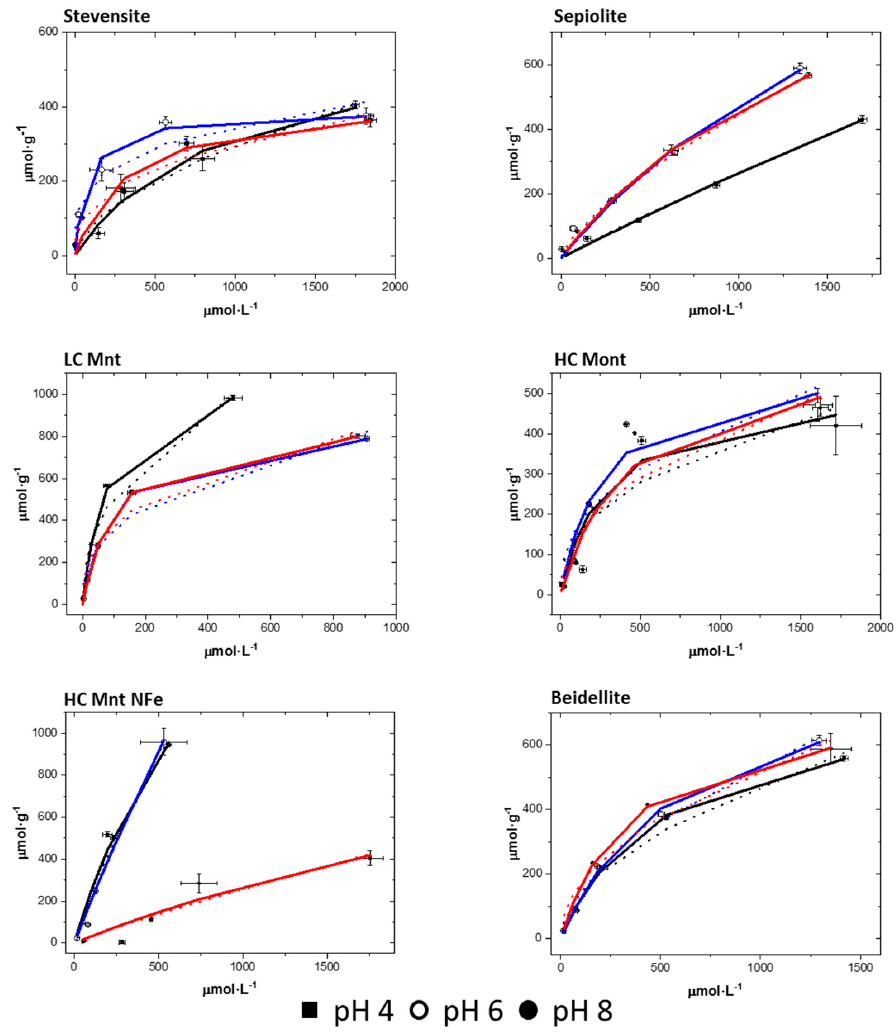
Figure 8. pH dependence of TC adsorption isotherms for sepiolite and smectitic materials at 25 °C in 0.1 M of NaCl aqueous media. pH = 4 in black; pH = 6 in blue; pH = 8 in red. Solid lines correspond to Langmuir fit. The Freundlich model fitting is plotted as dots. Freundlich and Langmuir models are inserted for comparison. Fitting parameters are listed in Table 3 (Freundlich) and Table 4 (Langmuir).